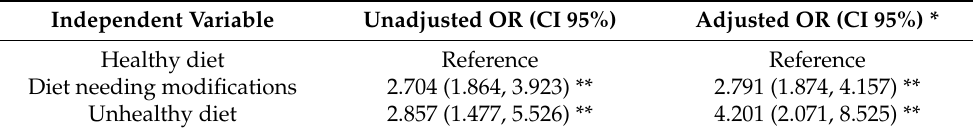
* Adjusted for age (continuous), gender (male/female), physical activity (low/medium/high), perceived social class (lower/middle/upper), BMI (<18.5 kg/m 2 /18.5–24.9 kg/m 2 / ≥ 25 kg/m 2 ), smoker (yes/no), problem- atic alcohol use (yes/no), academic performance (continuous), relationship status (yes/no) and screen time (continuous). ** p <